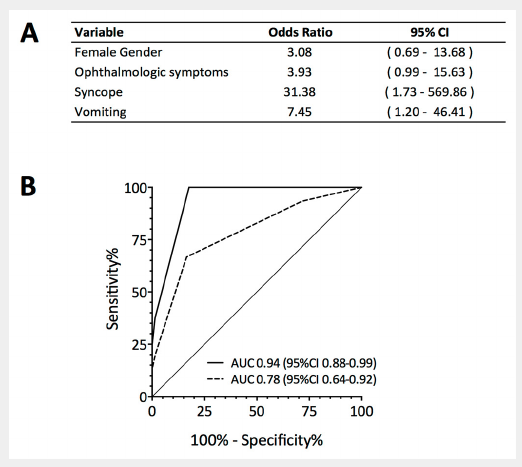
Figure 3 Statistical modelling and data visualisation using a ROC analysis of factors associated with significant magnetic resonance imaging (MRI) findings in headache patients. (A) Factors identified in binary, stepwise logistic regression analysis to be associated with significant MRI findings. (B) ROC analysis of a clinical score based on syncope (2 points), vomiting (1 point), ophthalmological symptoms (1 point), and female gender (1 point). Visualisation of a score cut-off of 2 points is displayed. Line indicates ROC analysis for “all significant findings that potentially caused headache”. Dotted line indicates ROC analysis for ‘all significant findings’. Score point distribution in the groups is indicated in figure S2 (appendix). AUC = area under the curve; ROC = receiver operating